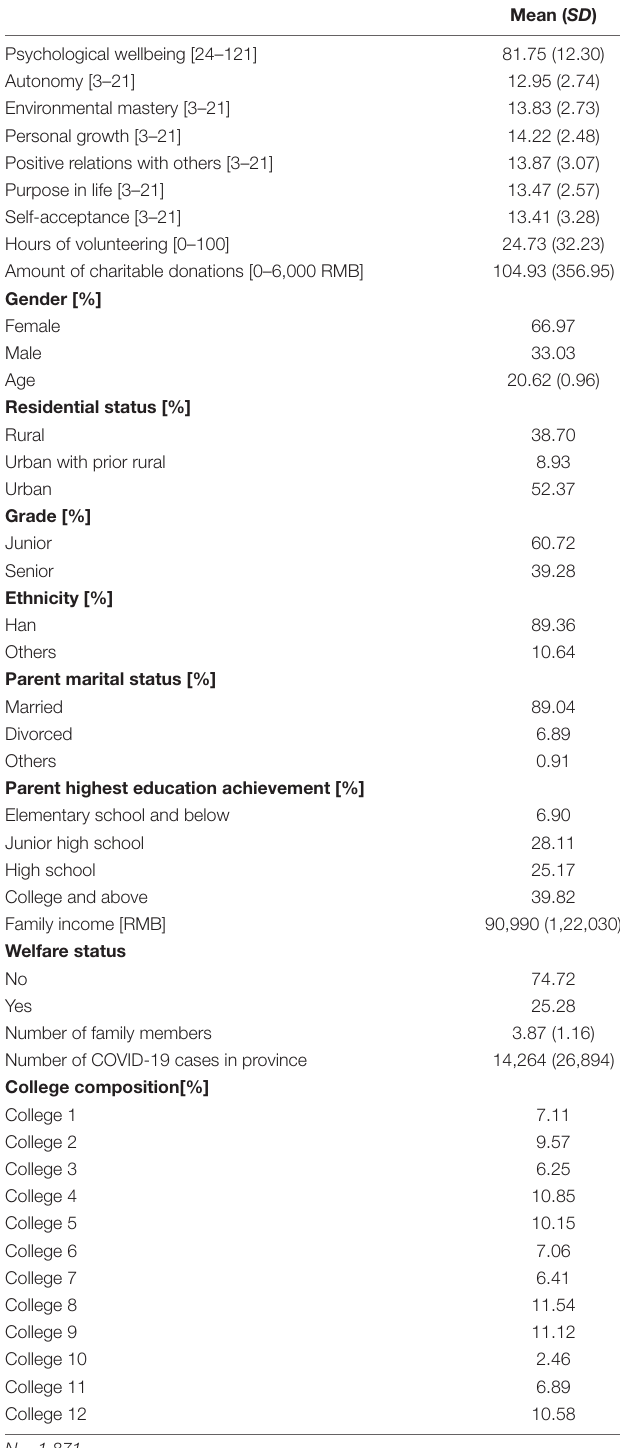
TABLE 1 | Descriptive statistics of main variables and